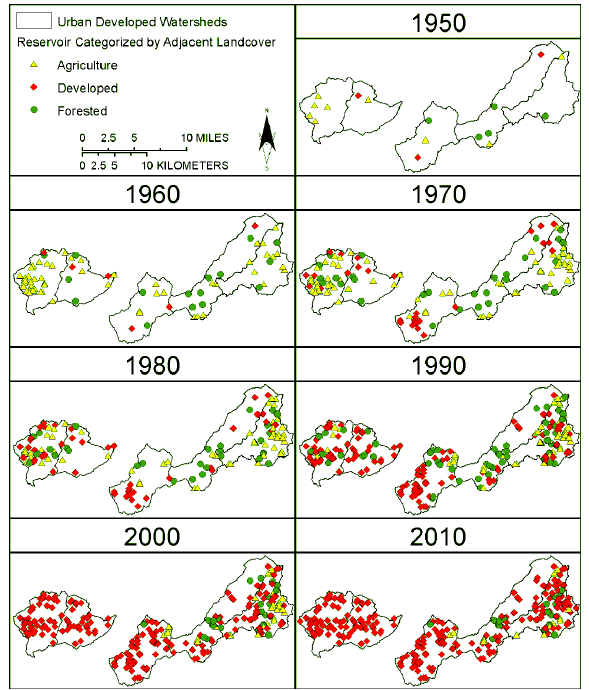
Figure 4. Map of reservoirs (classified by adjacent land cover) in urban developed watersheds,